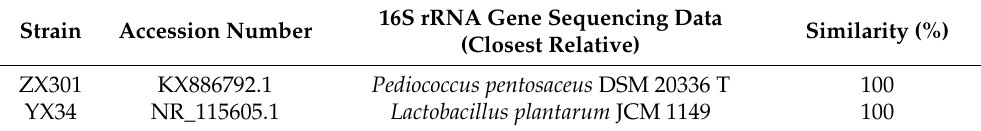
Table 3. The results of isolated lactic acid bacteria on the base of 16S rRNA gene sequences. Strain